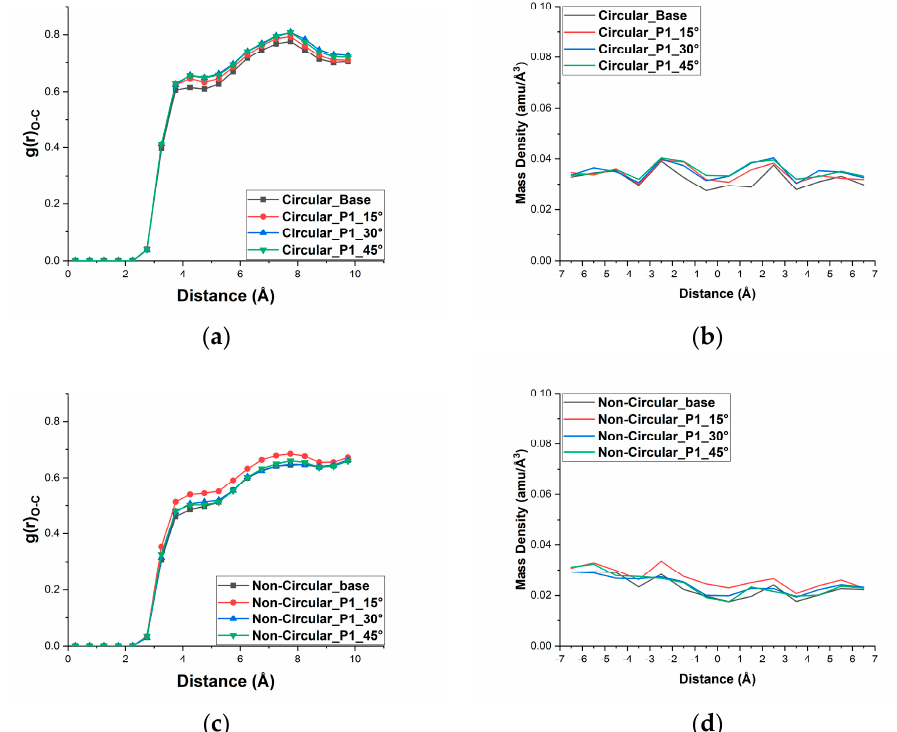
Figure 5. ( a ) Radial distribution function (RDF) of water molecules inside the circular pore with pattern 1 ( b ) density of water molecules inside the circular pore for pattern 1 ( c ) Radial distribution function (RDF) of water molecules inside the Non − circular pore with pattern 1 ( d ) density of water molecules inside the Non-circular pore for pattern 1.